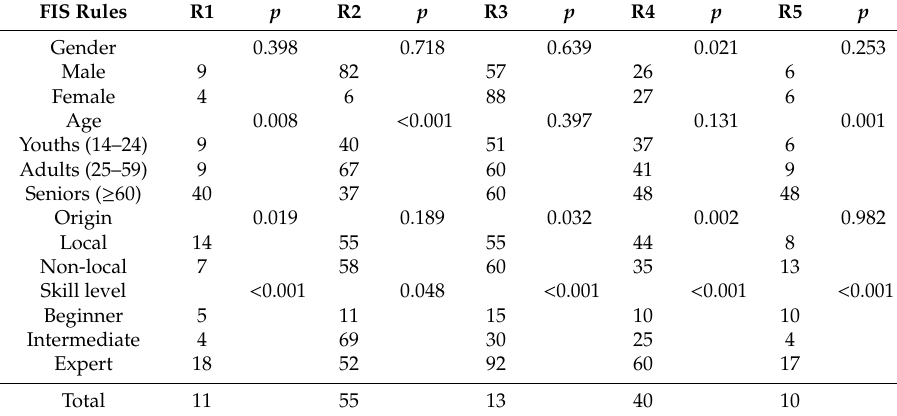
Table 6. Active knowledge of existing rules (*).